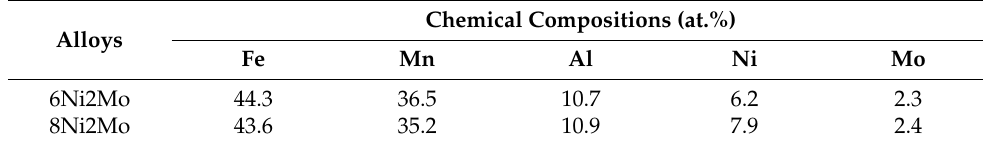
Table 1. Chemical compositions of Fe-Mn-Al-Ni-Mo SMAs.